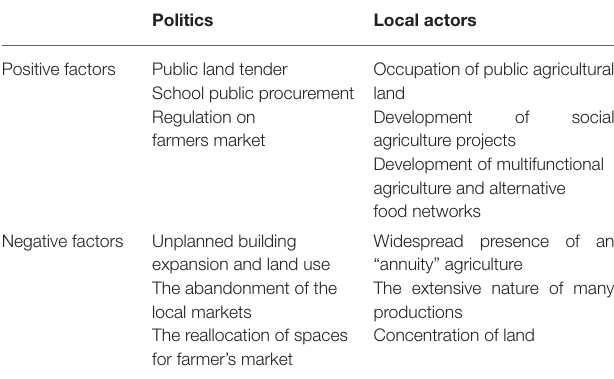
TABLE 1 | Negative and positive factors of the direct and indirect pressure of Roman local actors on politics during the years (source: